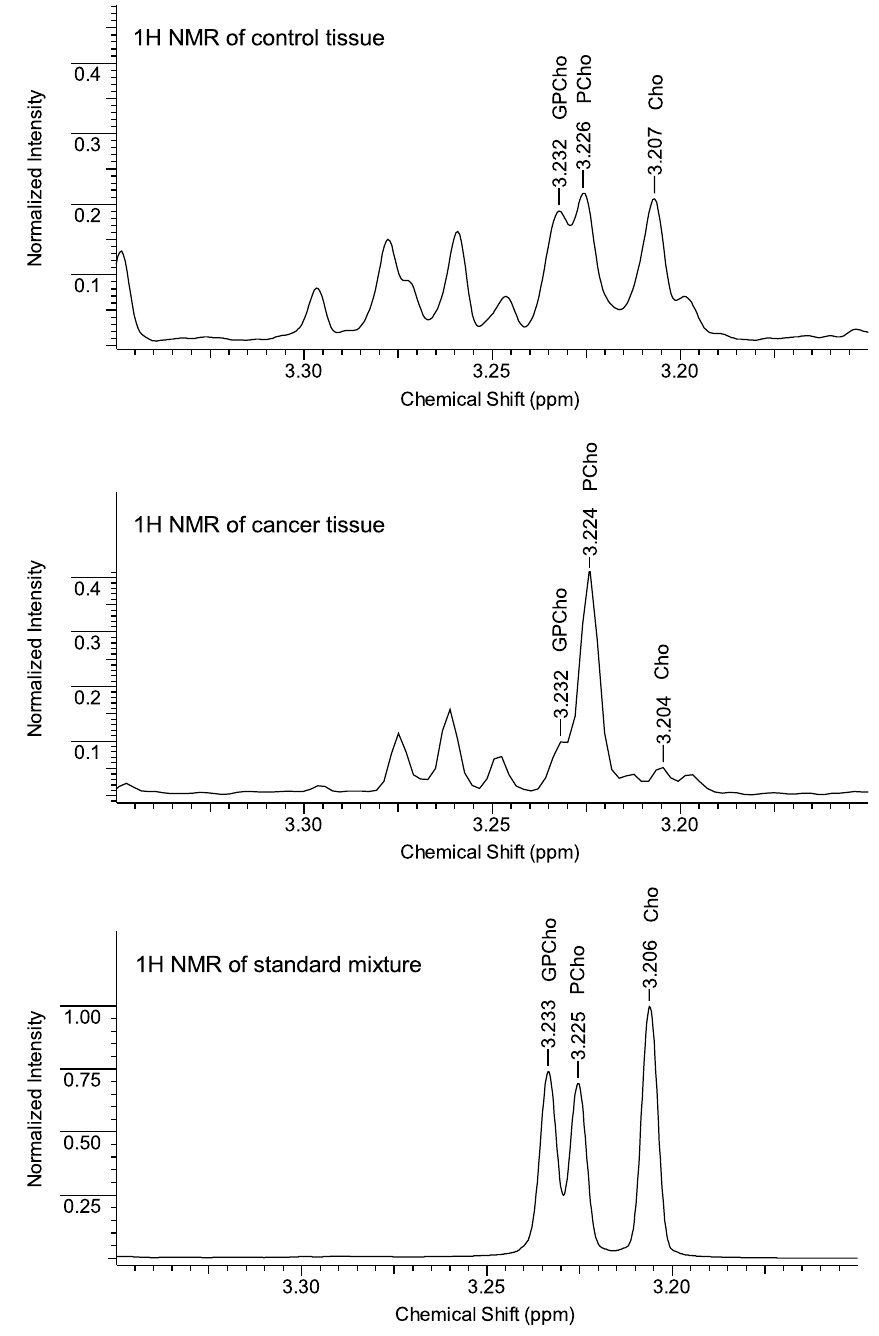
Fig. 6. Selected region from 500 MHz 1 H NMR spectra of biopsy aqueous extracts. The top and middle panel refer to healthy and cancerous breast tissue, respectively sample A-1 and sample A-2. The bottom panel refer to a mixture of standard Cho, PCho and GPCho in D 2 O. The measured pH of the three samples varied in the range 6,8-7,2. The N -trimethyl peaks of Cho and derivatives are labeled with the corresponding chemical shifts. The remarkable intensity differences are consistent with cancer-related metabolism